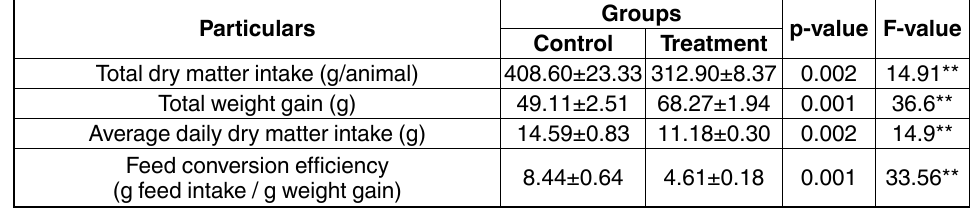
table 5. Average daily and total DM intake and feed conversion efficiency Particulars